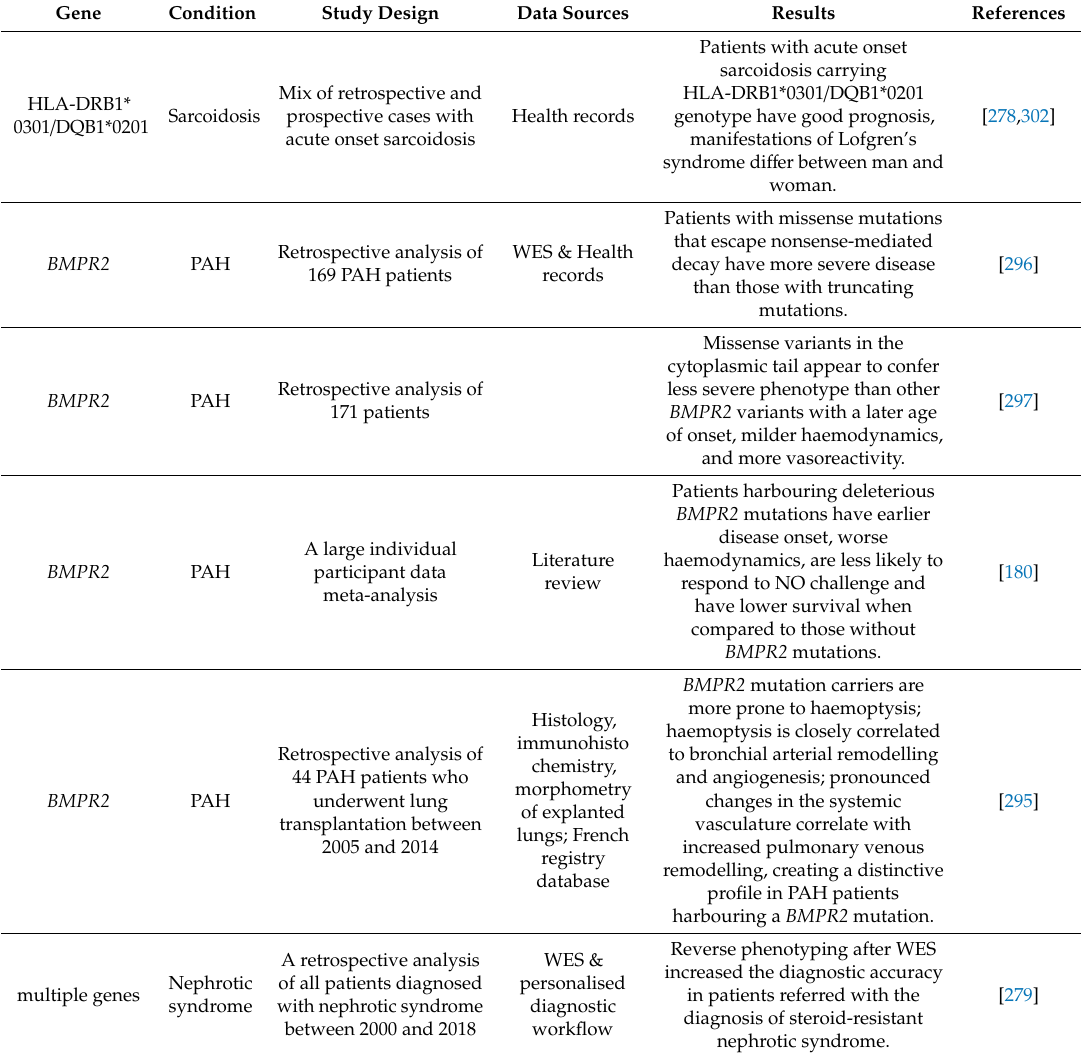
Table 4. Examples of successful studies that used reverse phenotyping. Abbreviations: BMPR2 —Bone morphogenic protein receptor type 2; PAH—pulmonary arterial hypertension; WES—whole-exome sequencing, * denotes allele